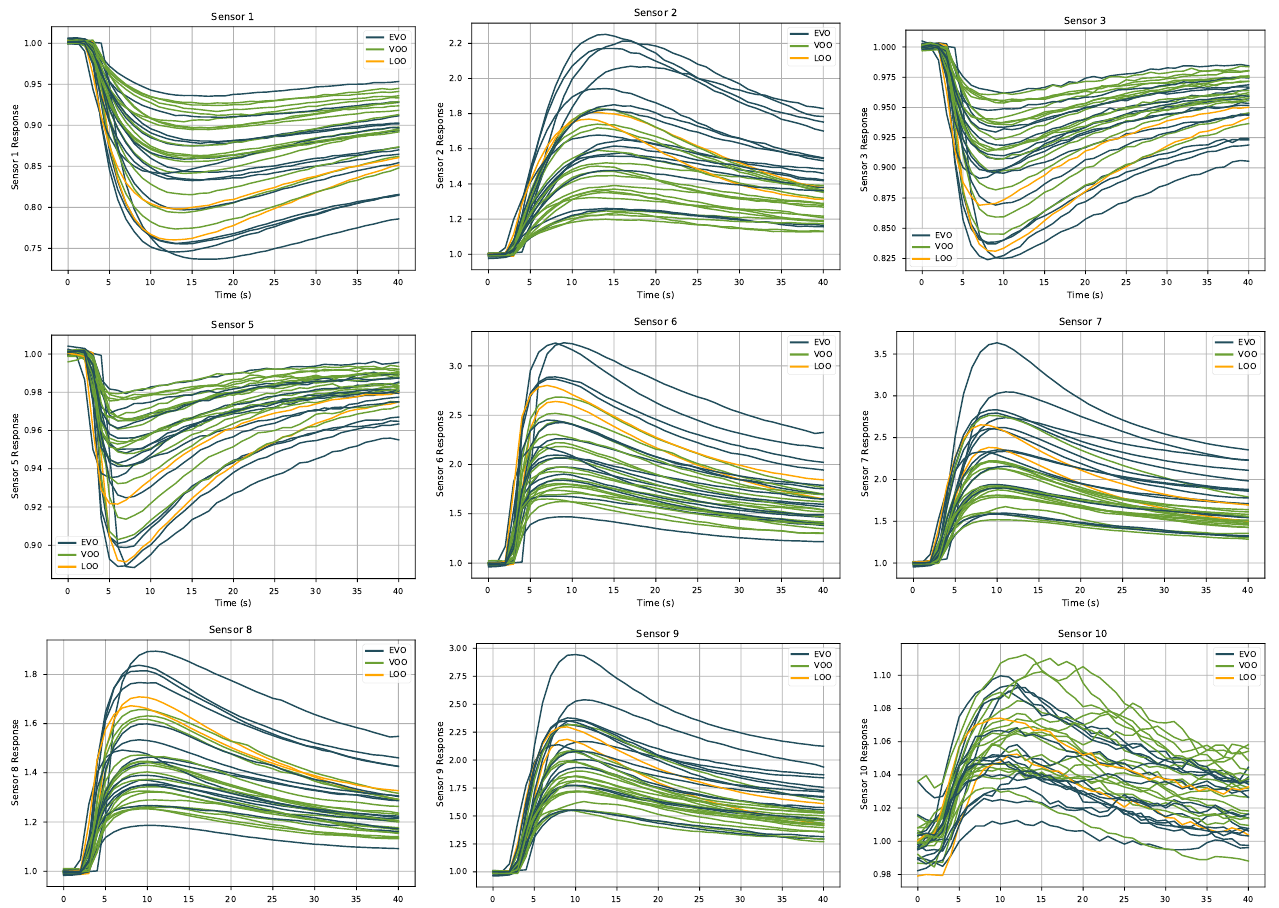
Figure 2. Curves of the responses of the nine sensors finally employed in the data analysis for the different